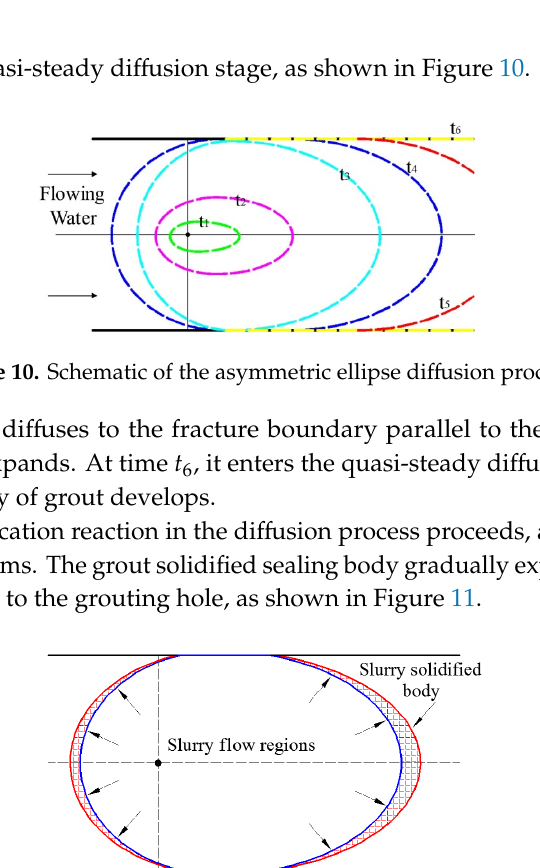
Figure 11. Formation process of waterpower infiltration jam.